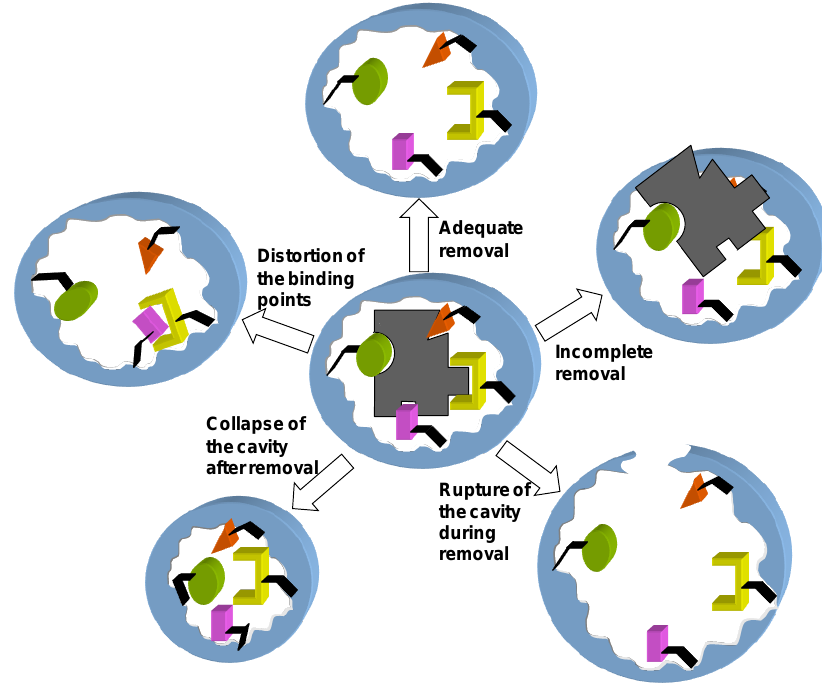
Figure 1. Scheme of the changes induced in the MIPs during the removal of the template.